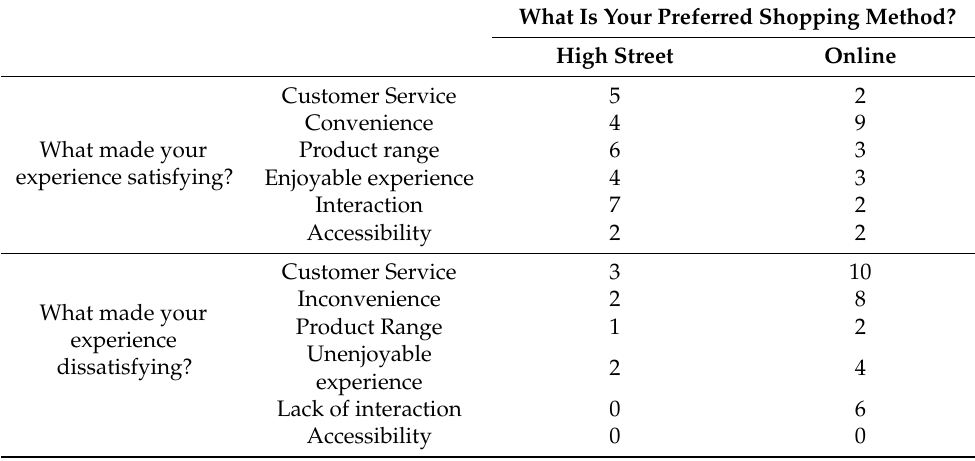
Table 5. What made your experience satisfying or dissatisfying?